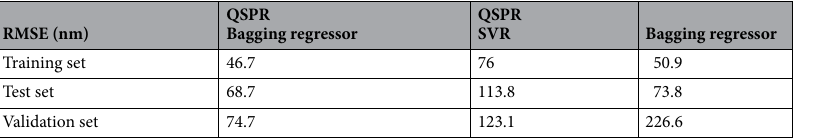
Table 1. Performance of the constructed models measured as root-mean-square error (RMSE, nm) for three data sets. QSPR: quantitative structure–property relationship, SVR: support vector